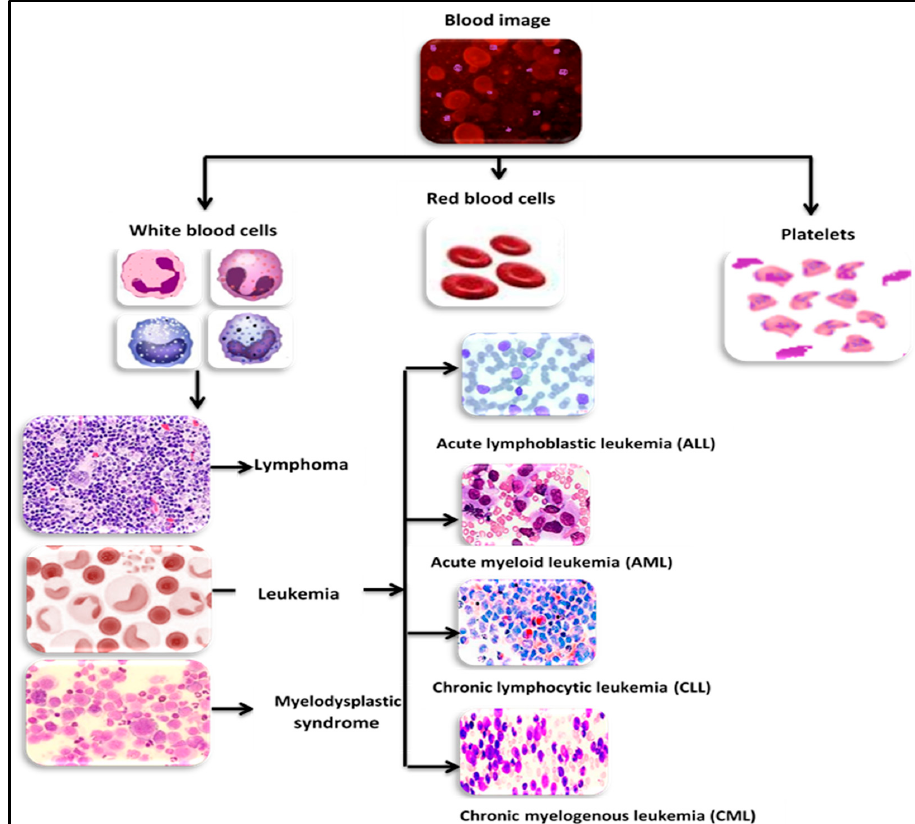
Figure 2. Types of leukemia in